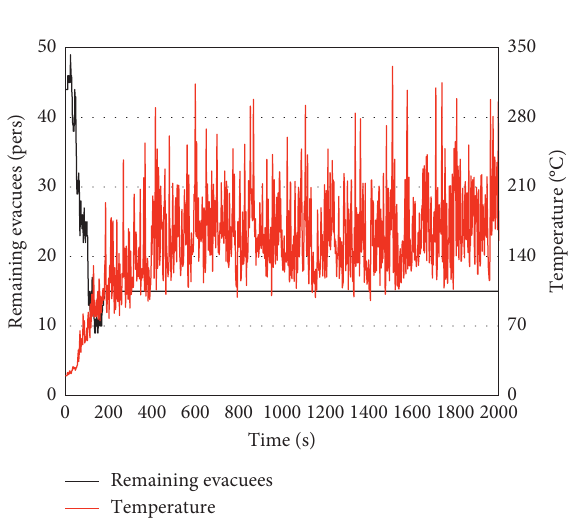
Figure 36: Evacuation and temperature changes of pedestrians in region